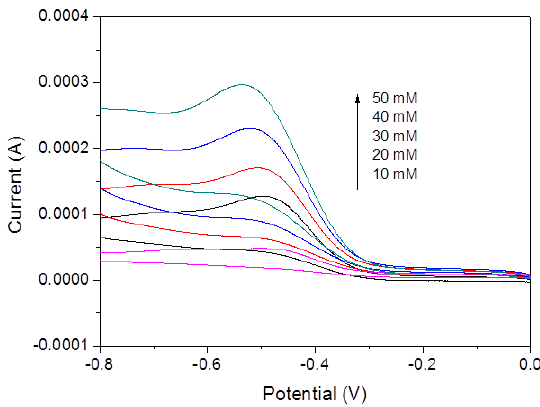
Figure 4. CVs of the fabricated GO–peptide–AgNPs/GCE by adding H 2 O 2 with different concentrations.